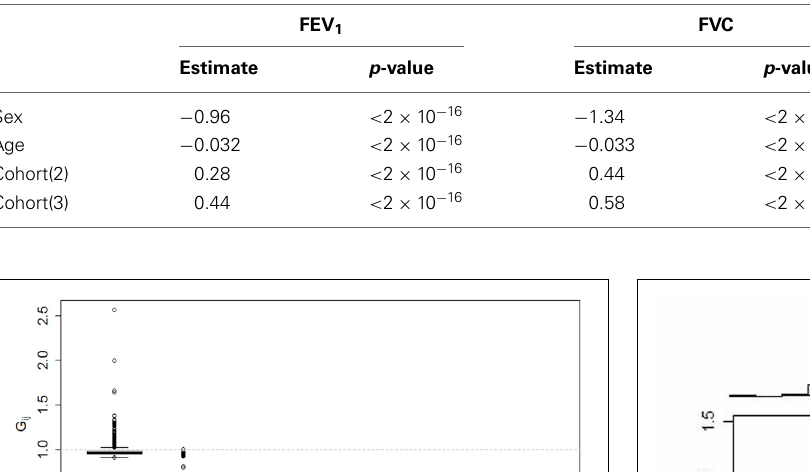
Table 1 | Estimated effects and p -values for sex, age, and cohort in relation to three pulmonary phenotypes.